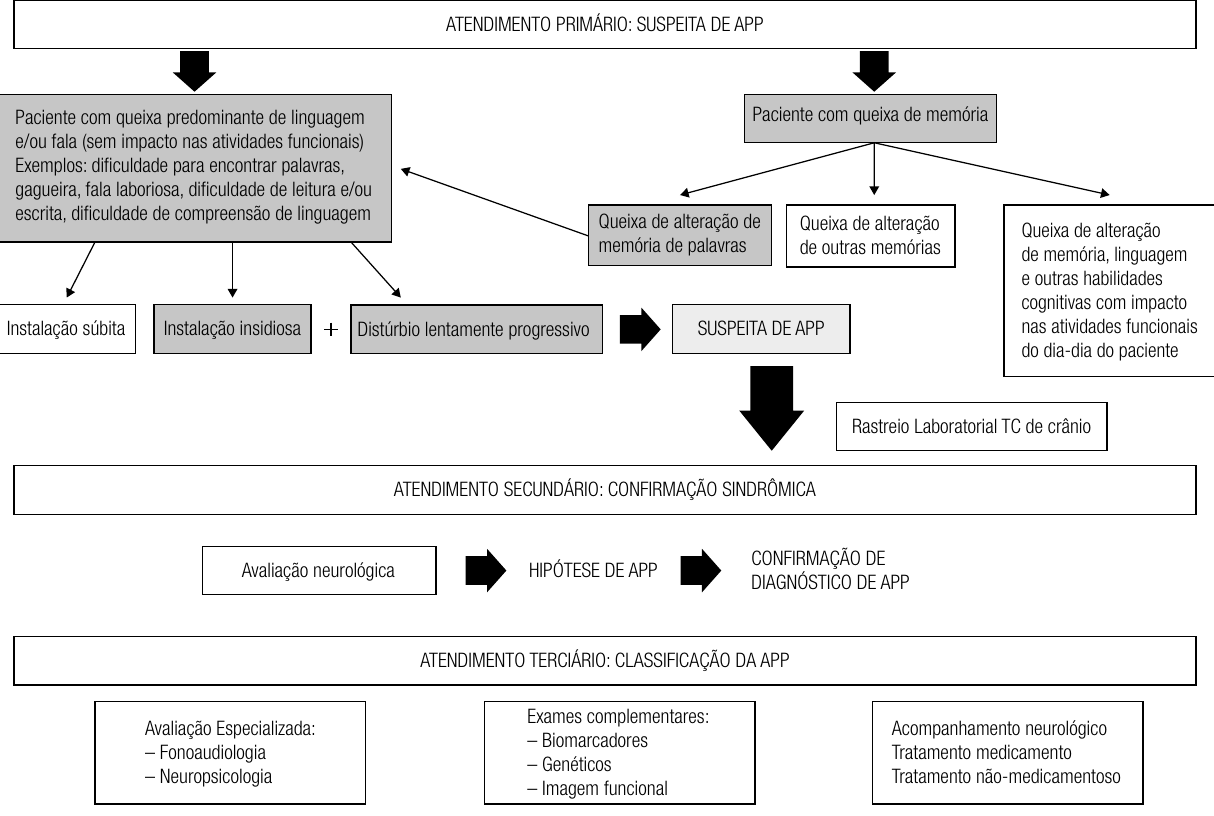
Figura 2. Abordagem da afasia progressiva